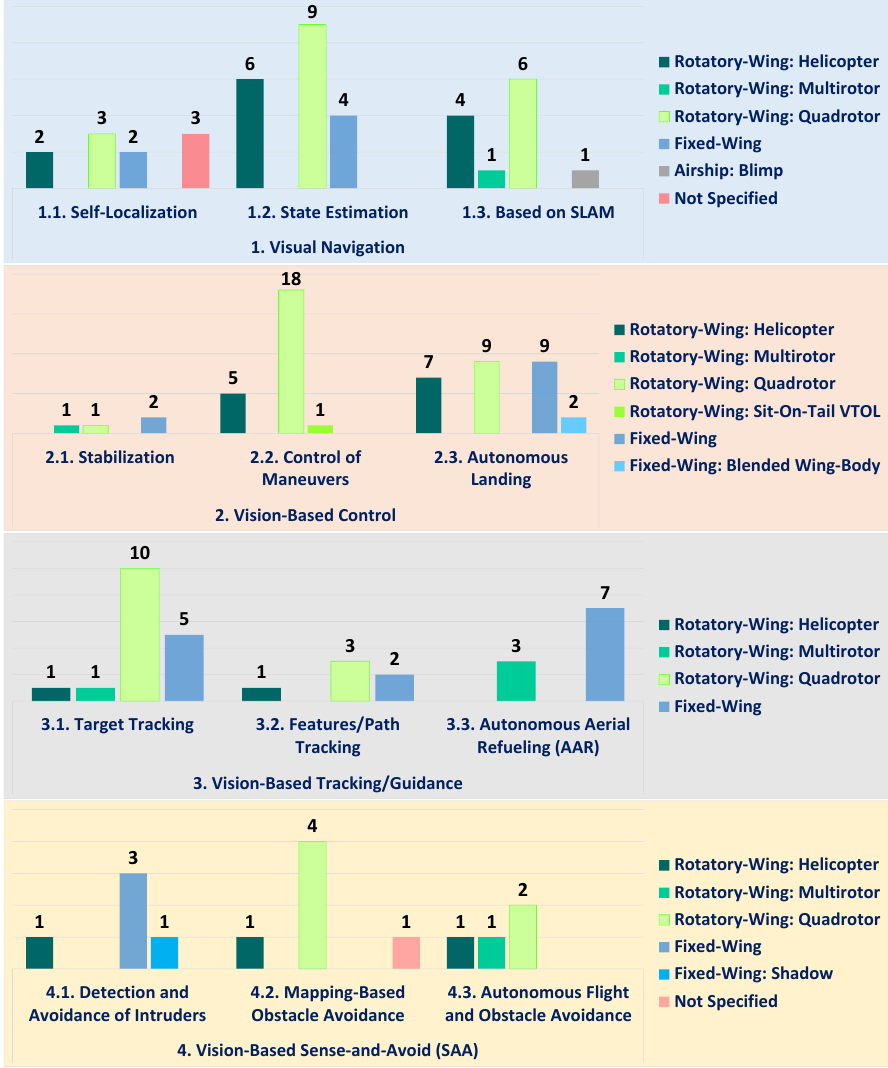
Figure 13. UAV class distribution over the